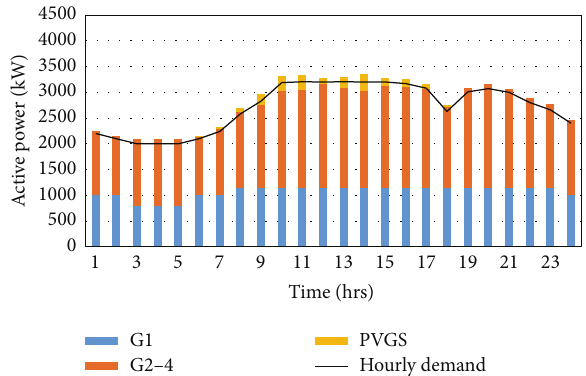
Figure 10: Voltage profile at Bus 4 with and without PVGS.